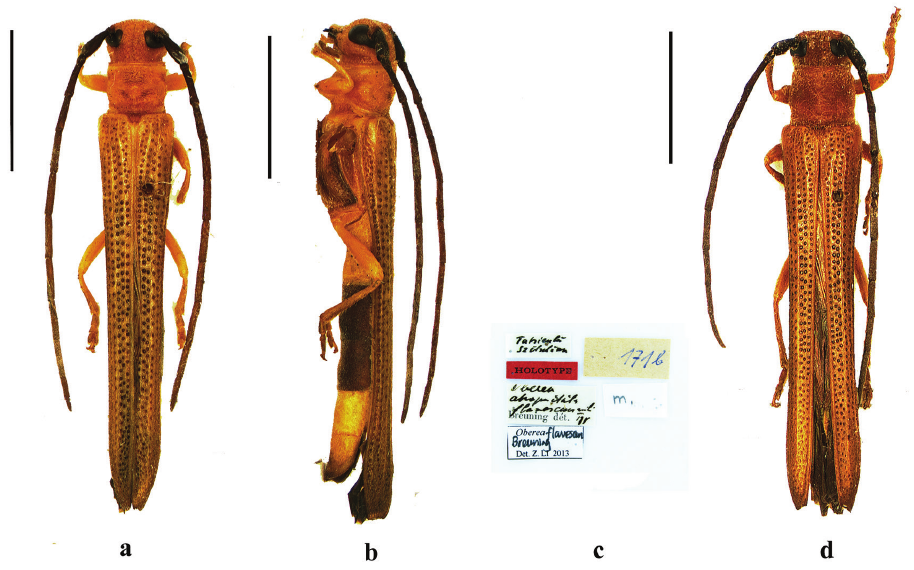
Figure 1. Habitus of O. flavescens Breuning, 1947, a–c holotype, female, from Sichuan a dorsal view b lateral view c label (not to scale) d male, from Sichuan, dorsal view. Scale bar 5.0